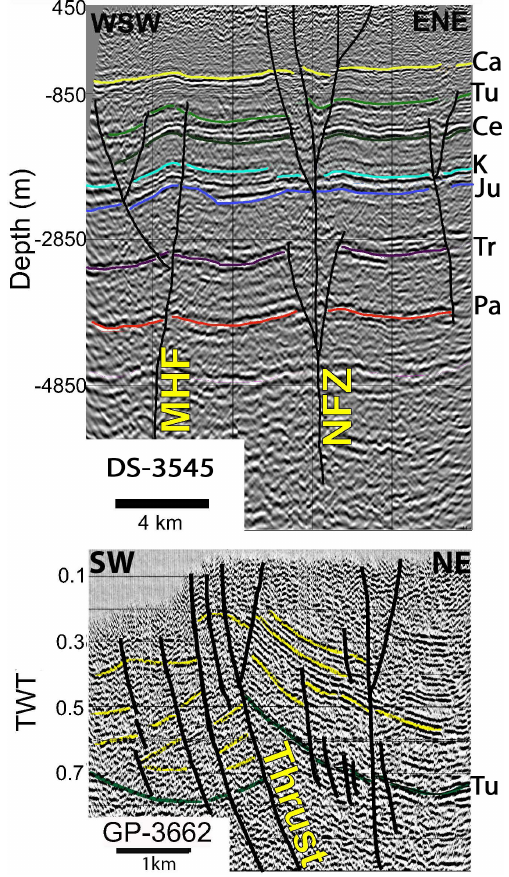
Figure 2. Seismic lines at southern Golan. (a) Seismic line DS-3545 showing a flower structure reinterpreted following Meiler (2011). Vertical scale in meters. (b) Seismic line GP-3662 showing the thrust fault reinterpreted following Bruner and Dekel (1989). Verti- cal scale in two-way